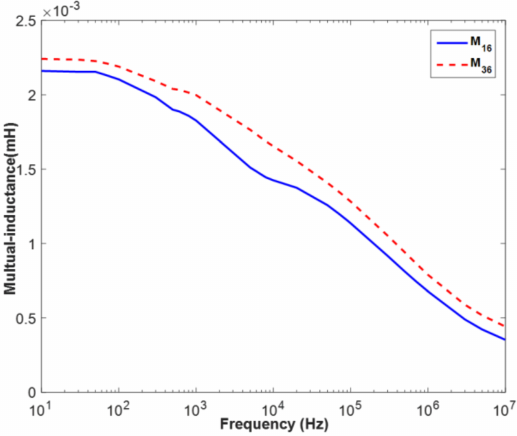
Figure 6. The frequency-dependent mutual inductances of the transformer winding, M 16 and M 36 .